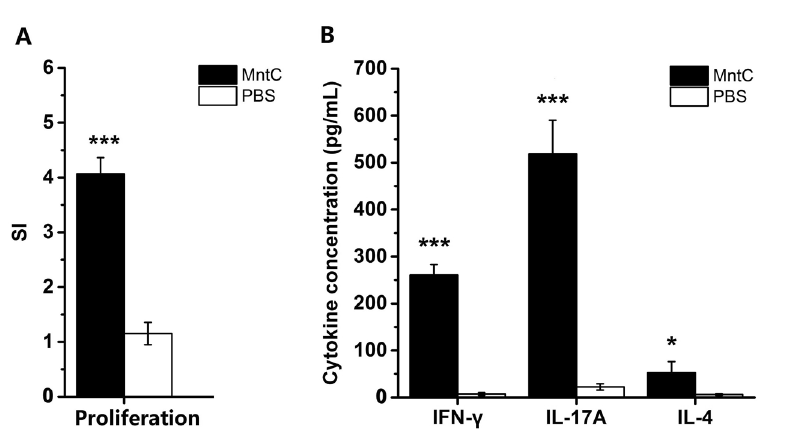
Figure 4. Proliferative responses and cytokine secretion of MntC-vaccinated CD4 + T cells in mice. ( A ) Proliferative response assay. One week after the last immunization with MntC or PBS, spleen lymphocytes were isolated from BALB/c mice (n = 5), and CD4 + T cells were incubated with 1 mg synthetic peptides plus mitomycin C-treated naïve syngeneic feeder cells for 1 day, at a ratio of 5: 1 × 10 5 cells. A significant difference was observed, which was in comparison with the PBS negative control group. ( B ) Secretion levels of IFN- γ , IL-17A and IL-4 of CD4 + T cells were determined by ELISA. The solid bars represent the mean values ± standard deviation (SD). Significant differences were indicated by ( * P < 0.05), ( ** P < 0.01) and ( *** P <